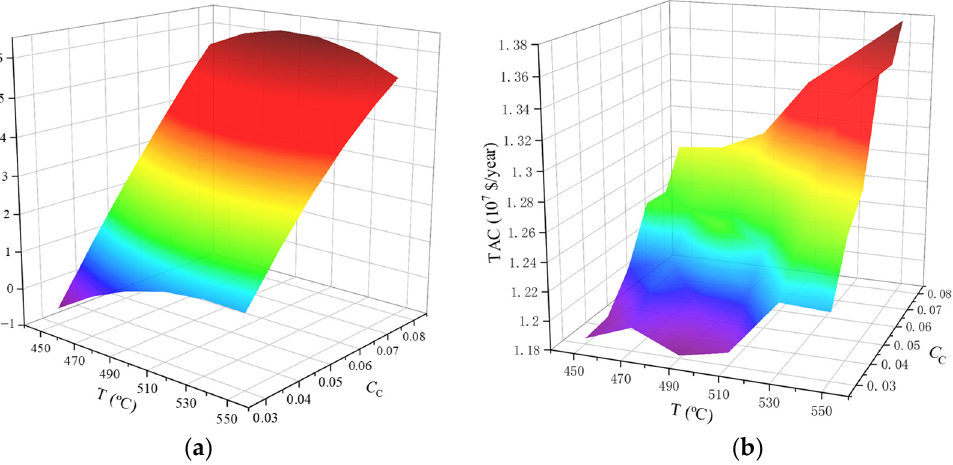
Figure 6. The maximum profit and the minimum TAC at different reaction parameters. ( a ) Maximum profit of the reaction–separation system ( b ) Minimum TAC of separation section.